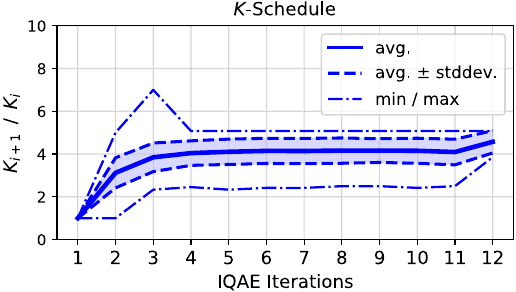
Fig. 5 Analysis of constant overhead for Clopper-Pearson IQAE. The average (blue) and worst-case (orange) constant overhead for IQAE runs with different parameter